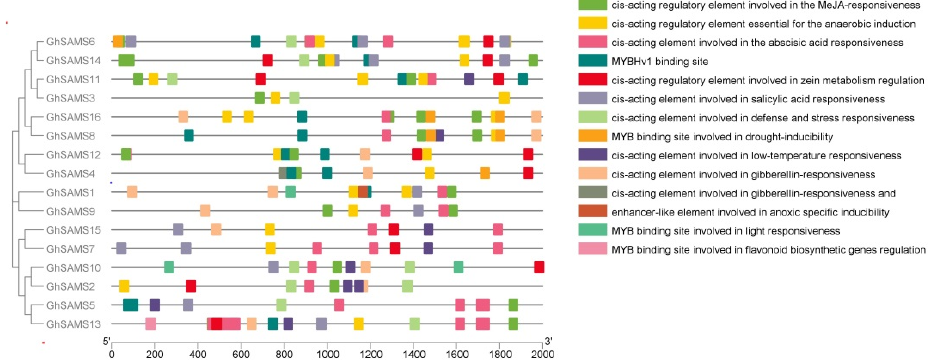
Figure 5. Predictive analysis of cis-acting regulatory elements in the promoter region of GhSAMS .